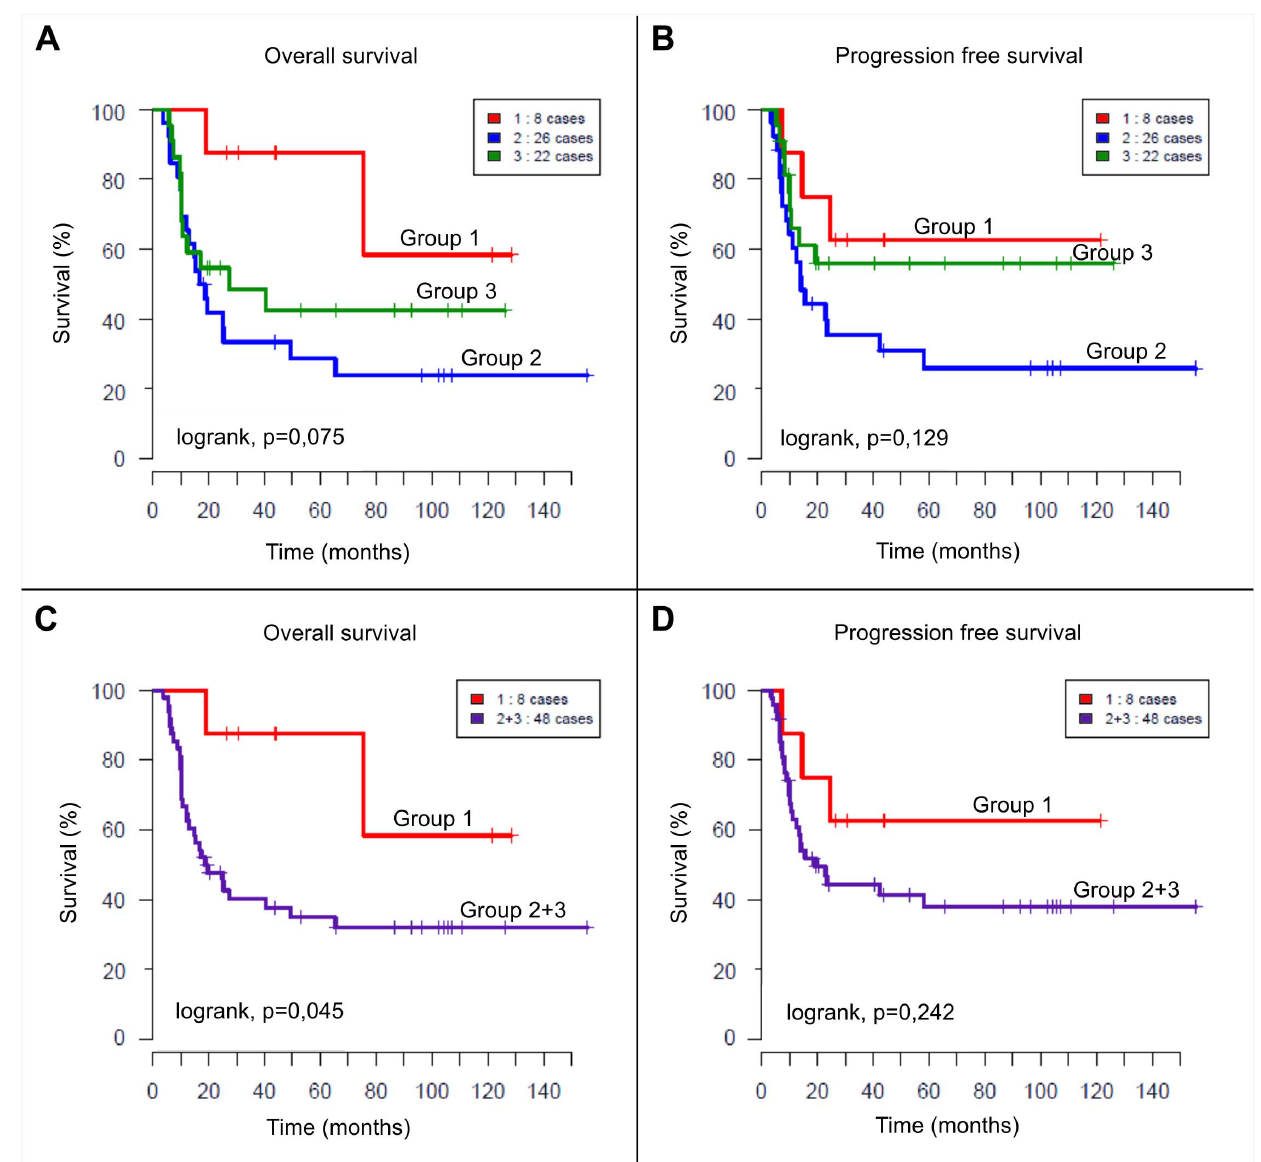
Figure 2. Kaplan Meier survival curves. ( A , B ) Overall survival and progression free survival curves of patients according to the 3 groups: group 1 (amplicon other than MYCN , not MYCN amplified, n=8), group 2 ( MYCN and other amplicons, n=26), group 3 (only MYCN amplification, n=22). Five- year OS rate was 87.5% 6 11.7%, 28.6% 6 9.2% and 42.4% 6 11.2% for groups 1, 2 and 3, respectively ( P =0.075). Five-year PFS rate was 62.5% 6 17%, 25.8% 6 9.2%, 55.9% 6 11% for groups 1, 2 and 3 respectively ( P =0.129). ( C , D ) Overall survival and progression free survival curves respectively for patients presenting NBs with amplification other than MYCN , without MYCN (group 1, n=8) and patients with at least amplification of MYCN (group 2 and 3 pooled together, n=48). Five-year OS rate was 87.5% 6 11.7% for group 1 and 34.9% 6 7% for group 2 + 3 ( P =0.045). Five-year PFS rate was 62.5% 6 17% for group 1 and 37.9% 6 7.7% for group 2 + 3 ( P =0.242).